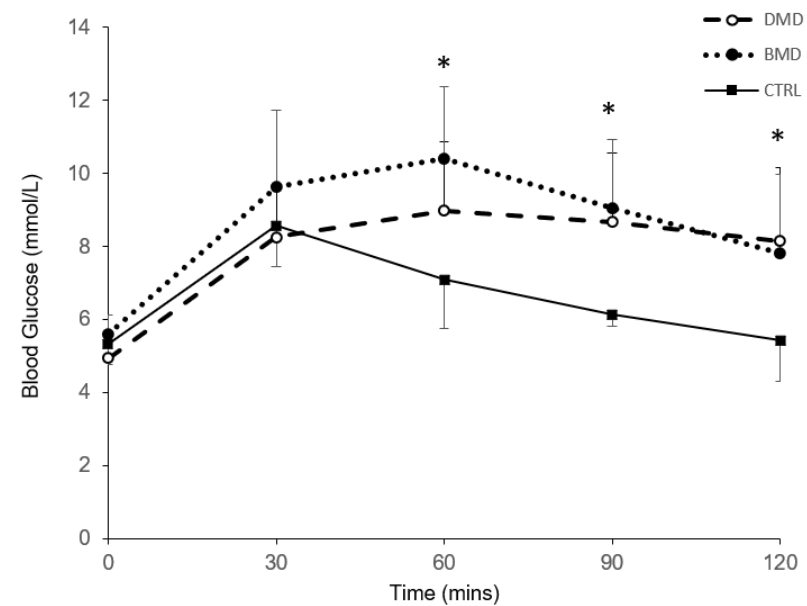
Figure 1. Blood glucose response to oral glucose intake. Blood glucose response to oral glucose intake in people with muscular dystrophy (MD) (Duchenne MD (DMD) dashed line, n = 15; Becker MD (BMD) dotted line, n = 13) and controls (solid line, n = 12). * denotes a significant difference between MD groups and controls ( p < 0.05).